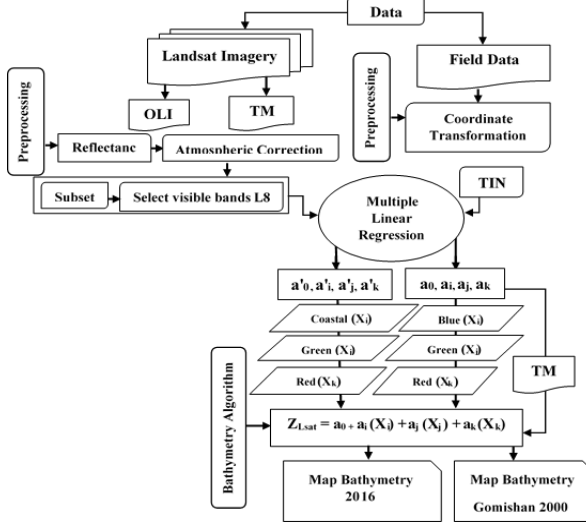
Figure 2. The steps of proposed methodology.